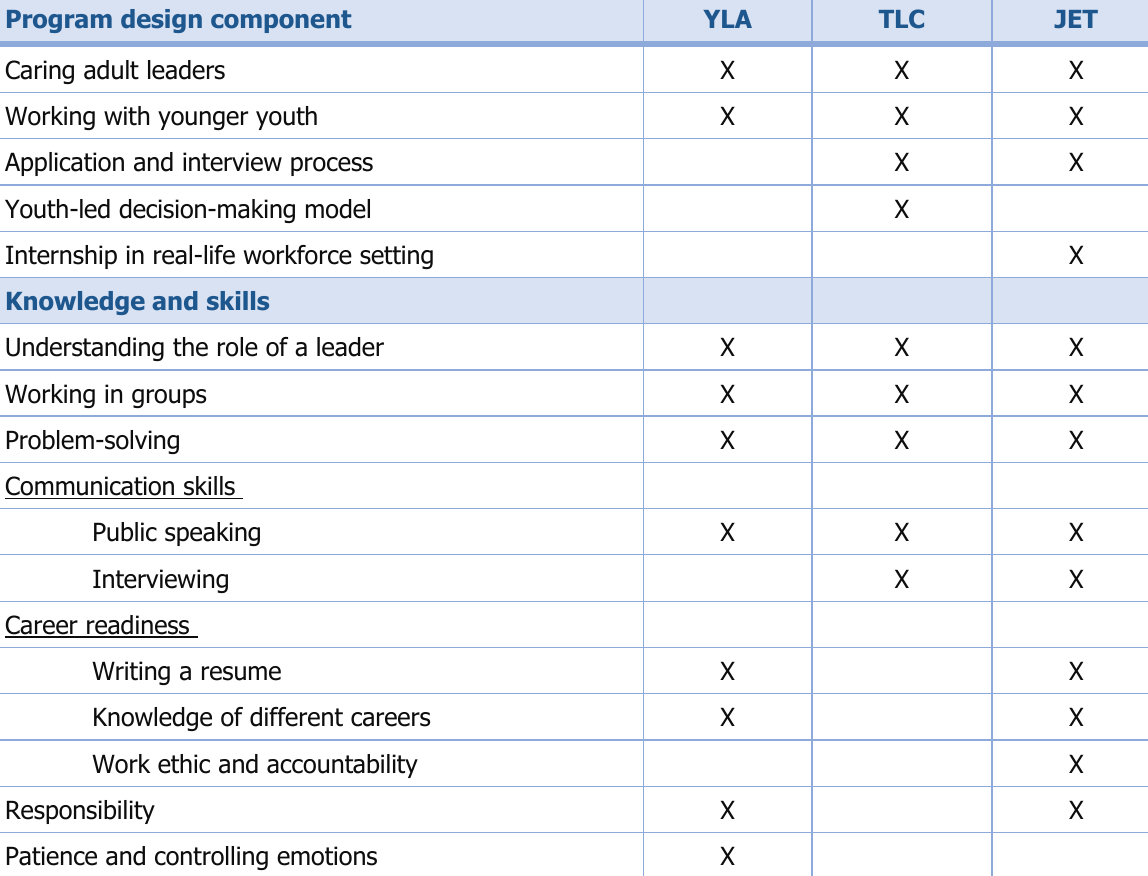
Table 3. Summary of Results on Program Design Components, Knowledge, and Skills Program design